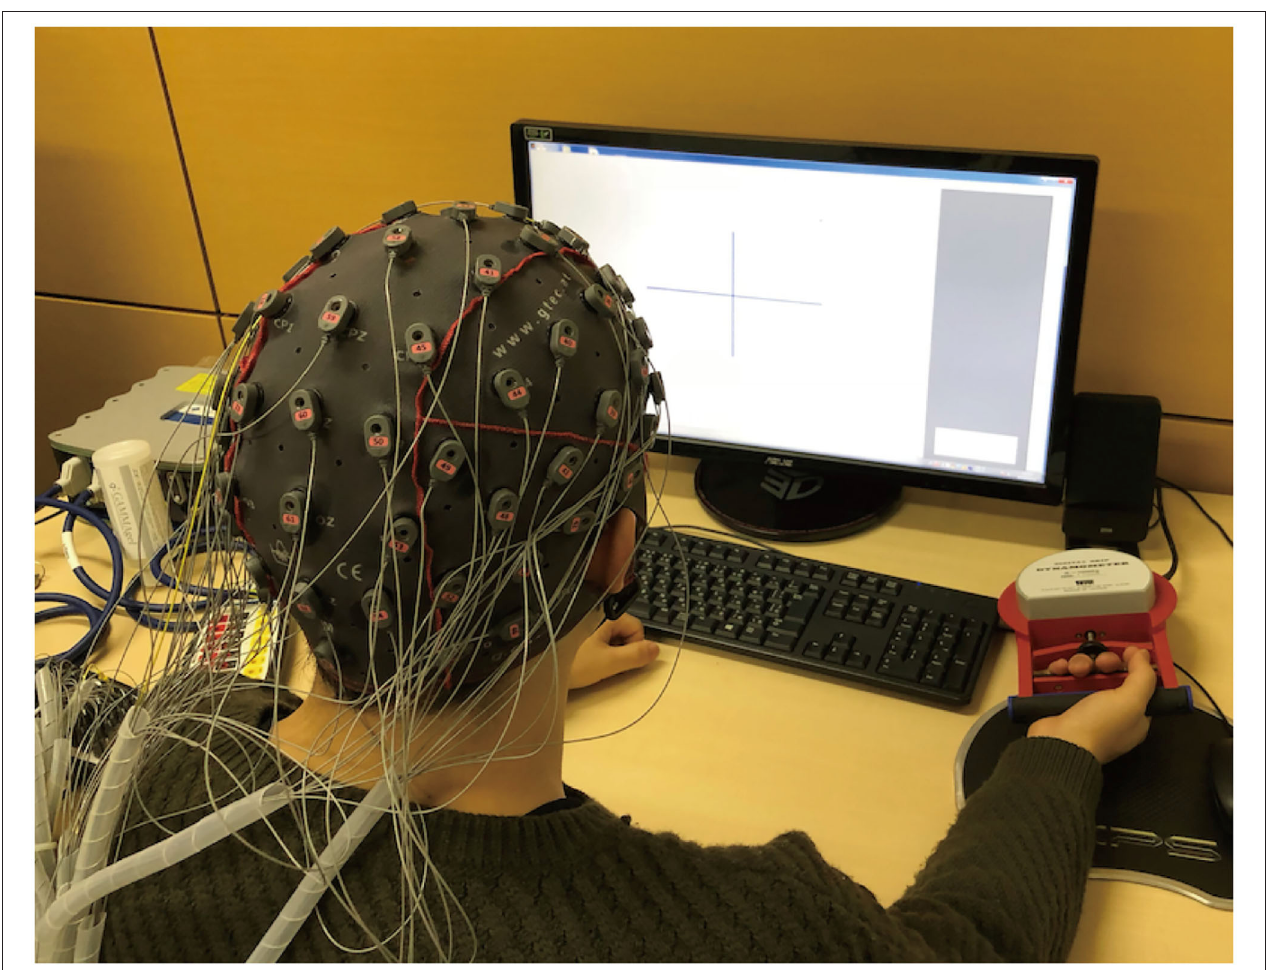
FIGURE 1 | Experimental setup. Participants wore an EEG cap with 64-channel active electrodes (g.Tec Inc., Austria). Participants were seated in a comfortable chair and placed their right arm on a table such that a group of muscles of their upper limb were relaxed against gravity. An LCD monitor was located in front of them, enabling viewing of a visual cue on the